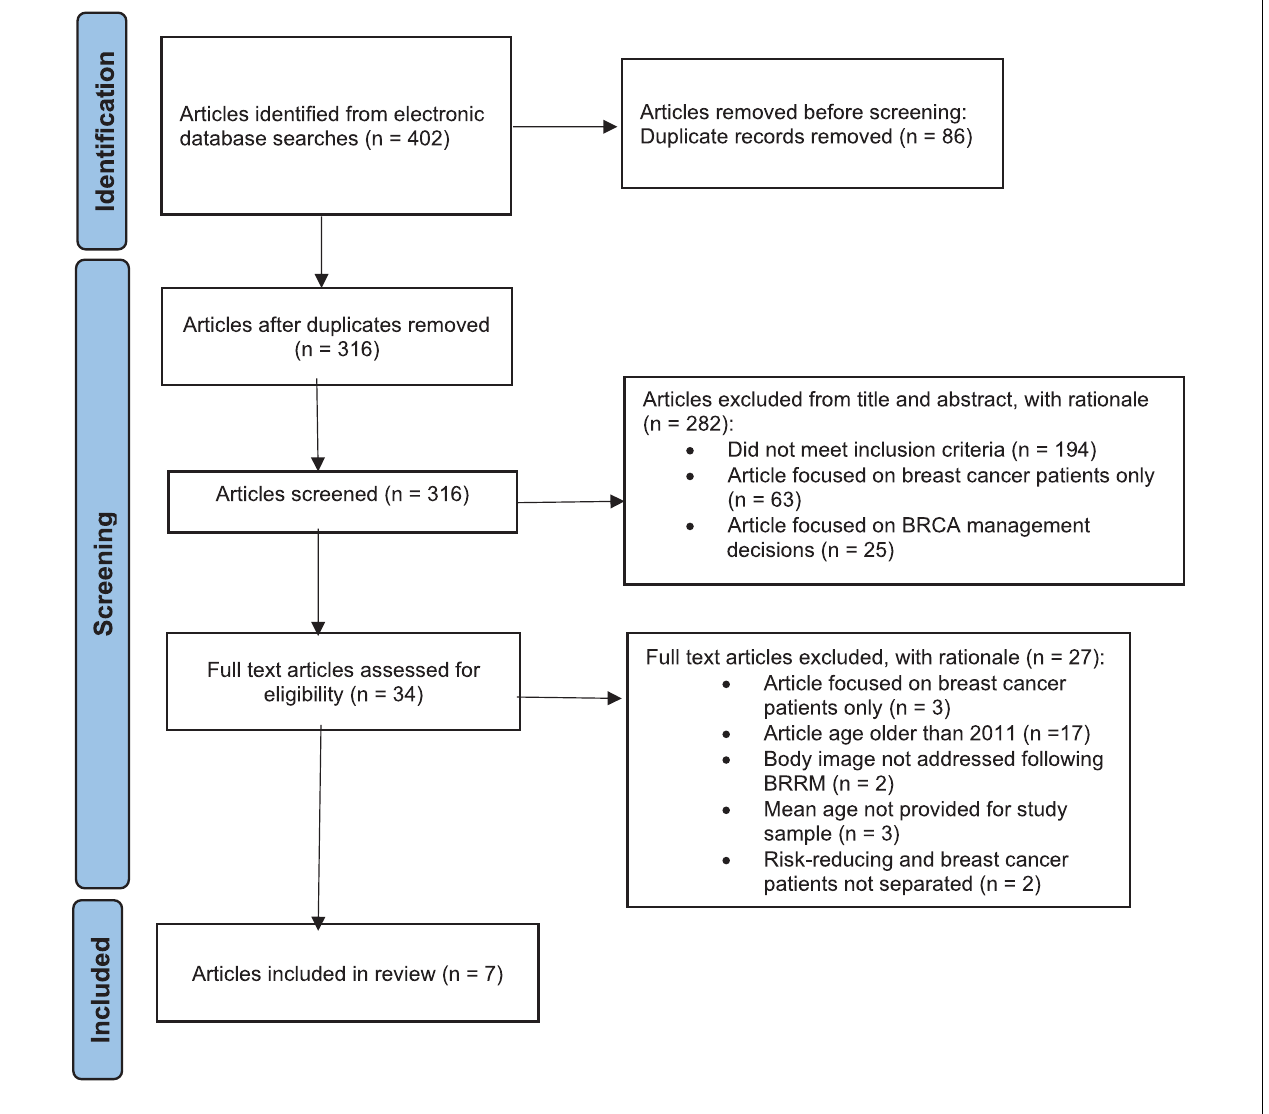
FIGURE 1 | PRISMA flow diagram for article